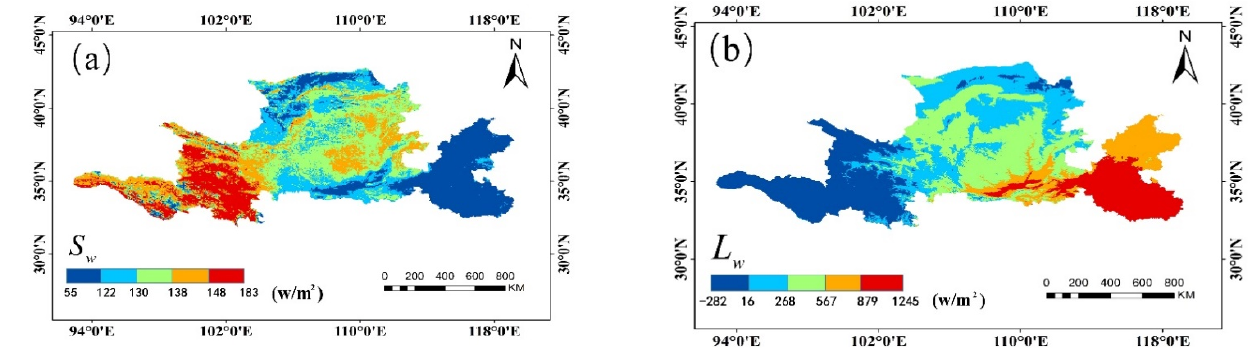
Figure 5. Spatial differences of ( a ) net shortwave radiation ( S w ) and ( b ) net long-wave radiation ( L w ) in the influence area of the YRB from 2000 to 2015.